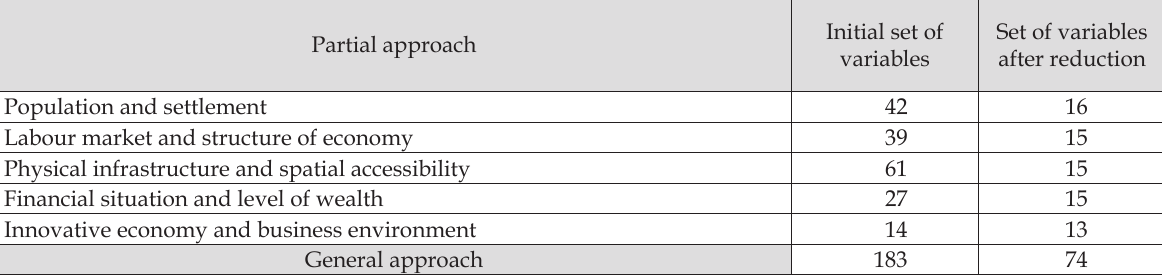
Table 1. Structure of the reduced geographical observation base adopted for the regional (NUTS 2) level Partial